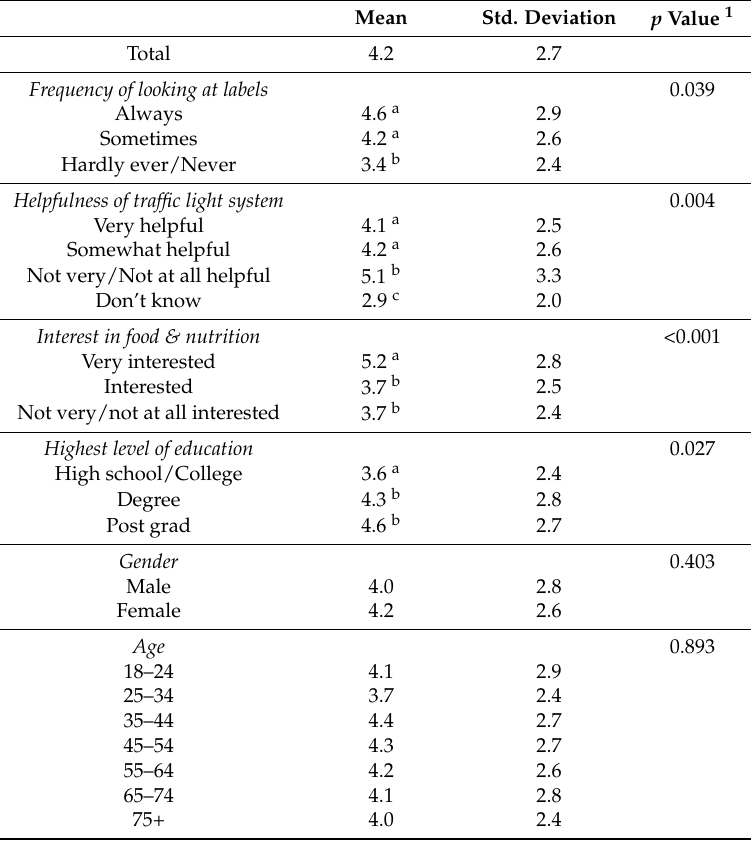
Table 3. Consumer score of correctly classified added sugars according to demographic and other general